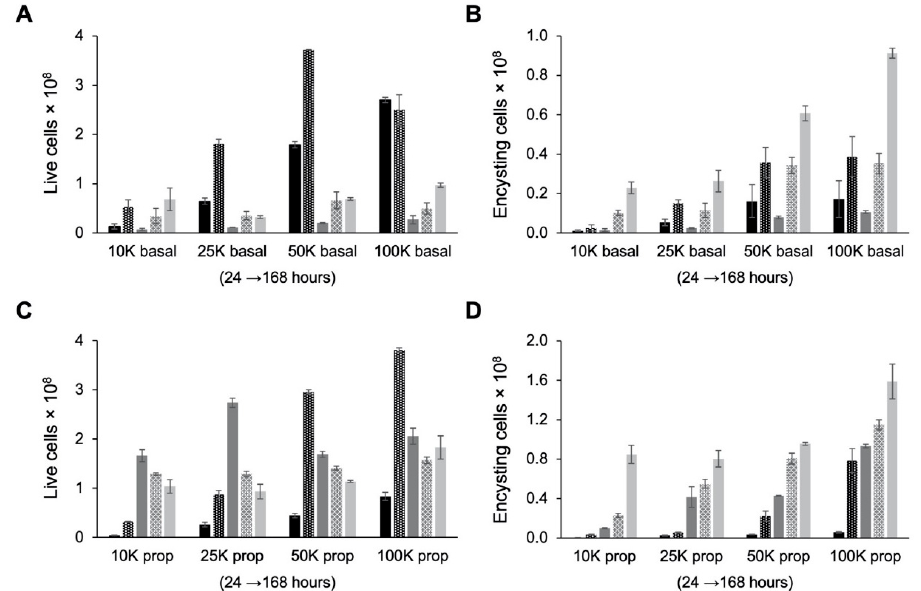
Figure 6. Effect of cell density on growth and encystation in TYI basal medium. Replicate E. histolytica cultures inoculated at 10,000 (10K), 25,000 (25K), 50,000 (50K), or 100,000 (100K) trophozoites/mL into TYI basal ( A and B ) or TYI propionate medium ( C and D ) were harvested at 24, 48, 72, 96, and 168 h (left to right for each set of cultures), stained with WGA-488, and analyzed by flow cytometry. ( A ) Live cell count in TYI basal cultures. ( B ) Percentage of live encysting cells in TYI basal cultures. ( C ) Live cell count in TYI propionate cultures. ( D ) Percentage of live encysting cells in TYI propionate cultures. Values are the mean ± standard deviation for three biological rep ‐